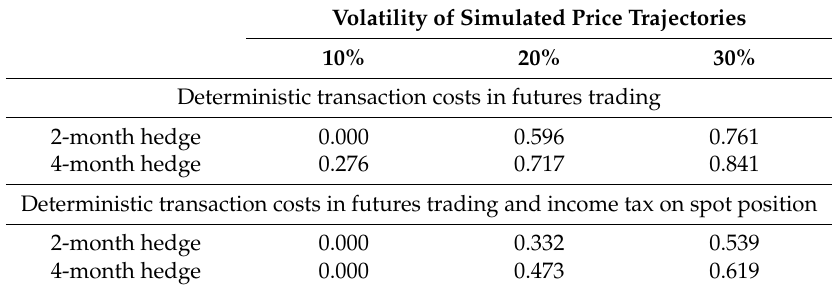
Table 5. Hedge ratios with deterministic transaction costs in futures trading.